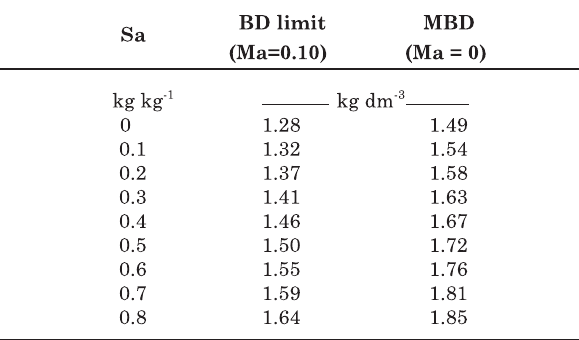
Table 7. Bulk density (BD) simulation in